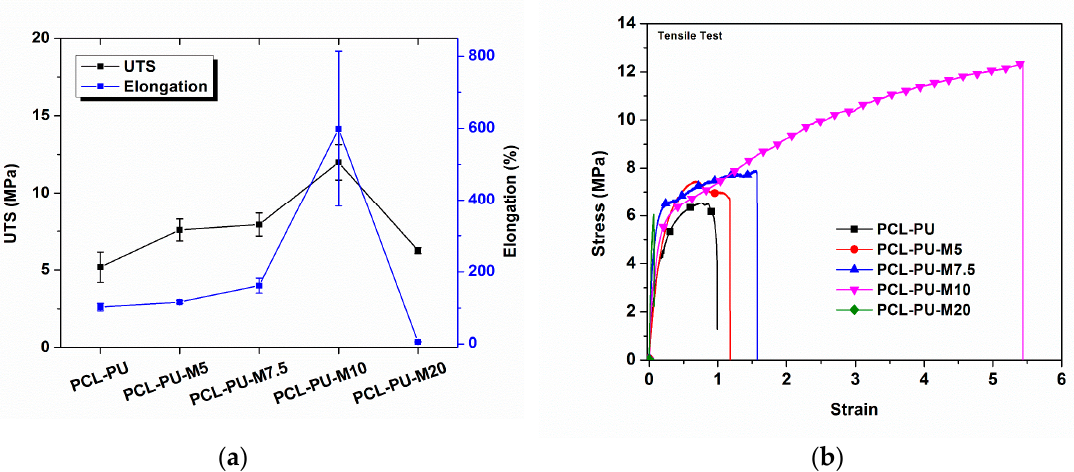
Figure 5. ( a ) Ultimate tensile strength (UTS) and elongation at break of the PCL-PU and PCL-PU-Chitosan polyurethane biocomposites and ( b ) representative stress vs. strain curve for the same.